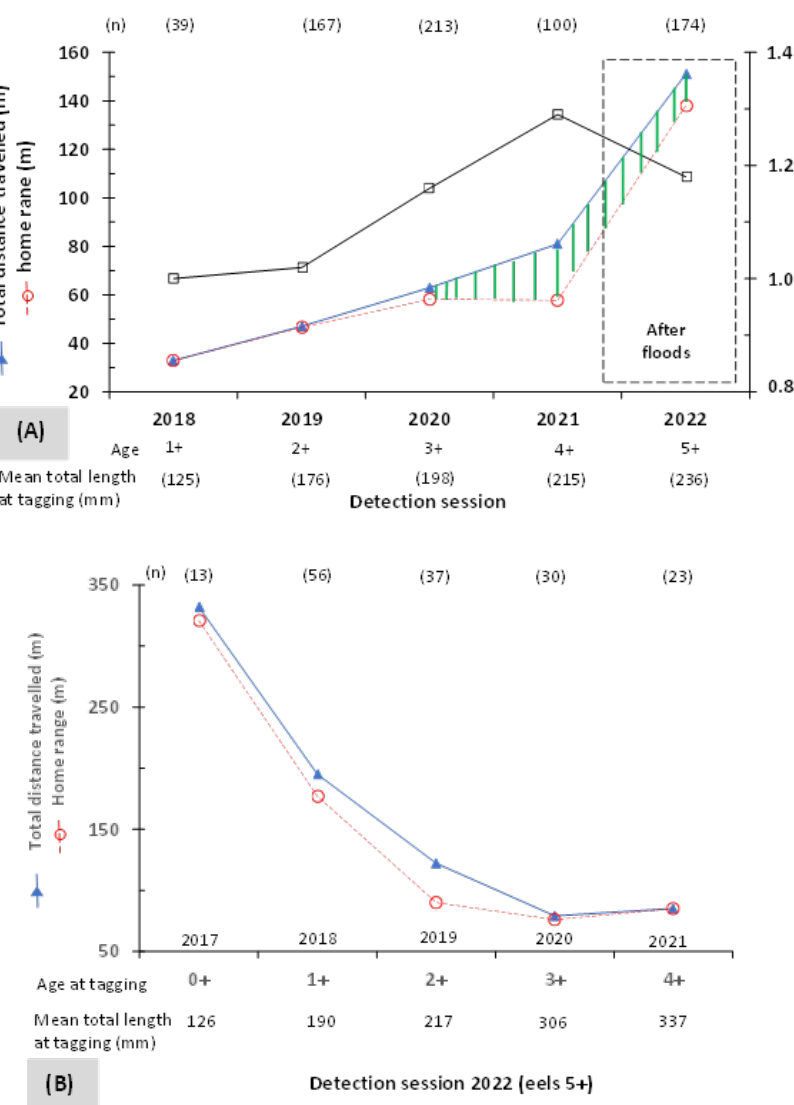
Figure 3. Mean development over time of the total distance travelled (TD), the home range (HR) and the exploitation index (EI) of HR of the tagged eels detected from the sessions in 2018 (1 + ) to 2022 (5 + ) ( A ). TD and HR are presented according to age and the total length at tagging for eels age 5 + ( n = 159) detected during the 2022 session ( B ). ( n ) indicates the number of detected eels. Age is relative to the age of the eels after restocking in 2017. The mean total length represents the total length at tagging for eels detected at each detection session. Green lines mark the area where the HR is less than the